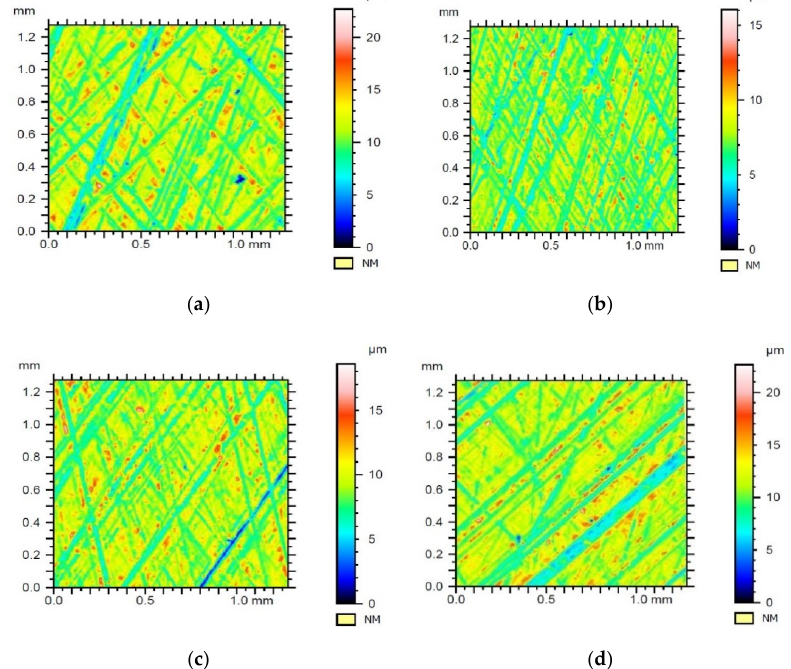
Figure 15. Surfaces of the samples tested with flat-top structures after their leveling and shape removal: ( a ) sample 1, ( b ) sample 2, ( c ) sample 3, ( d ) sample 4. ( a ) sample 1, ( b ) sample 2, ( c ) sample 3, ( d ) sample